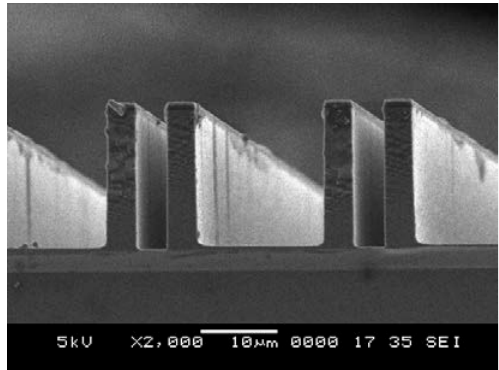
Figure 8. SEM image of the DRIE result after adjusting the process parameters.